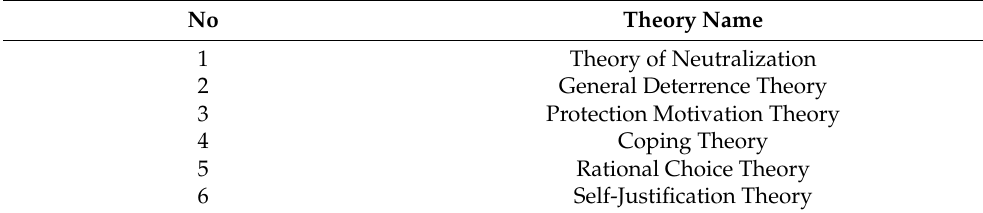
Table A4. Most common theories used for noncompliance